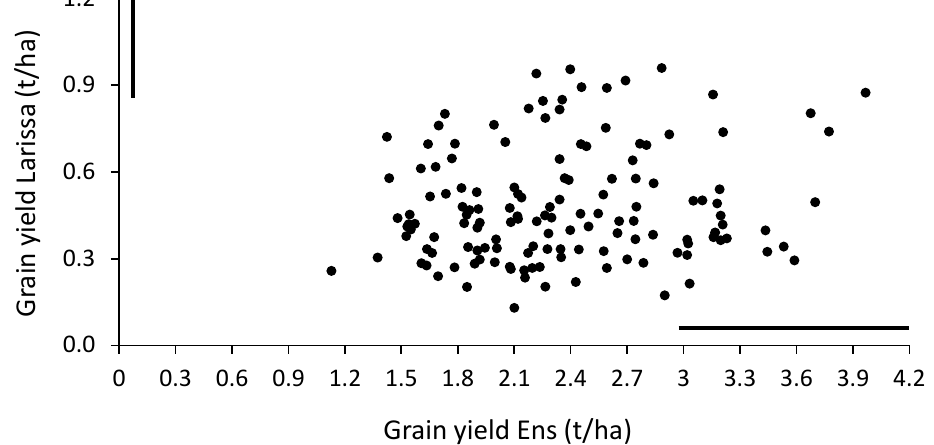
Figure 1. Grain yield of 140 white lupin inbred lines grown in Larissa (Greece) and Ens (the Nether- lands). The vertical or horizontal bars indicate least-significant difference values at p < 0.05 for line comparison in the relevant site.